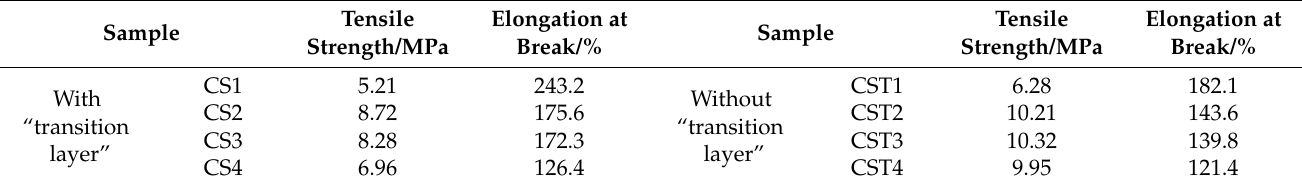
Figure 7. Stress–strain curves of the latex film (one of samples each latex). Table 6. Tensile strength and elongation at break of latex